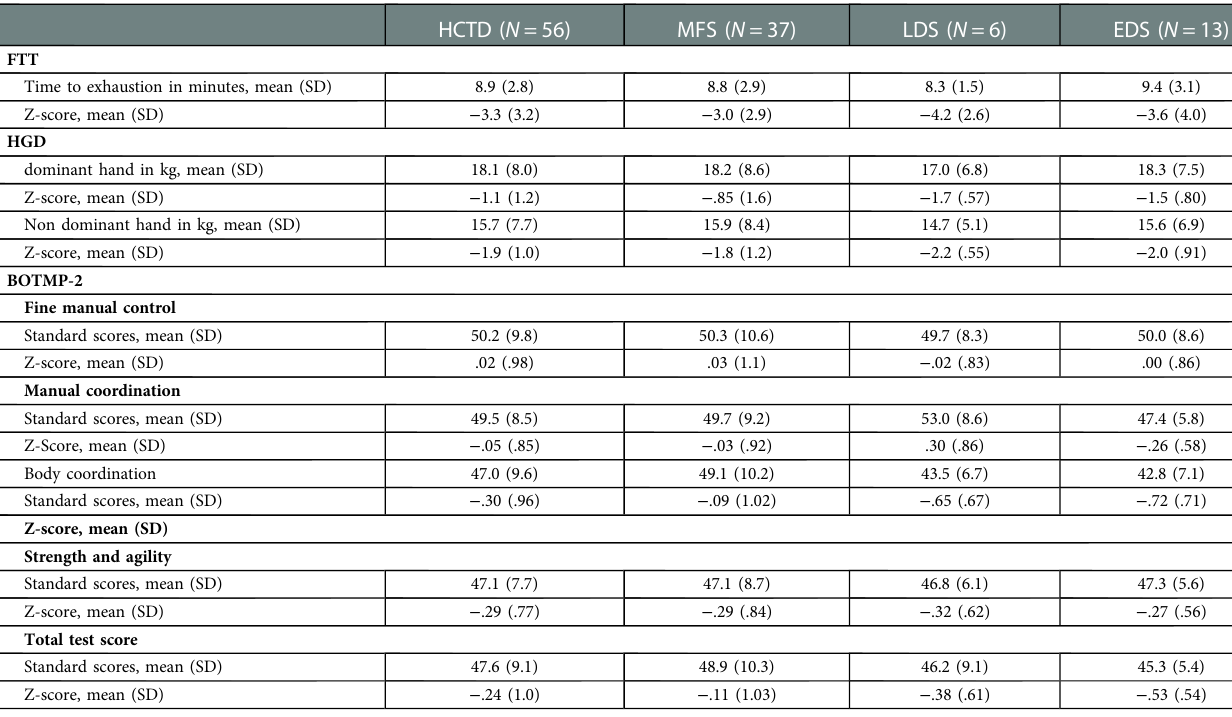
TABLE 3 Physical fi tness in children with